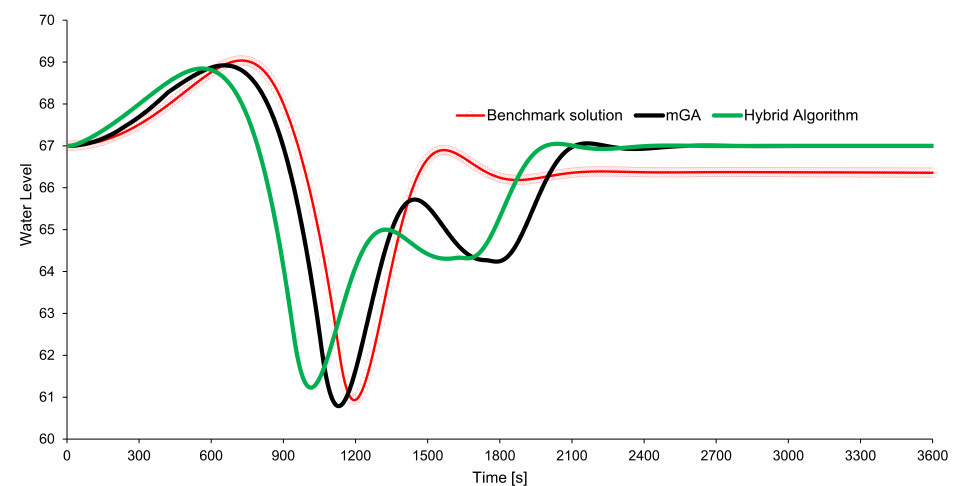
Figure 14. Changes of water level obtained with the benchmark solution (red line), the micro genetic algorithm solution (black line) and the metaheuristic hybrid algorithm solution (green line).